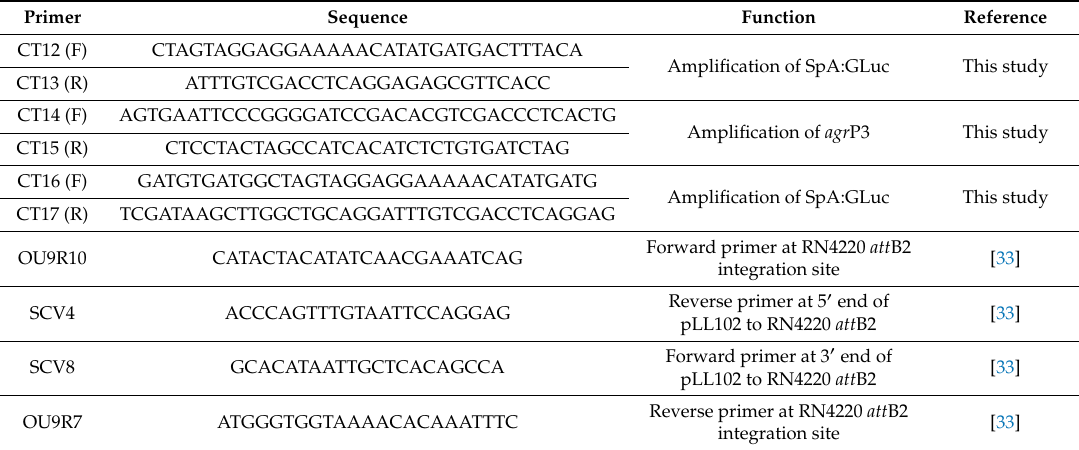
Table 2. Primers used in this study. All primers were sourced from Sigma Aldrich